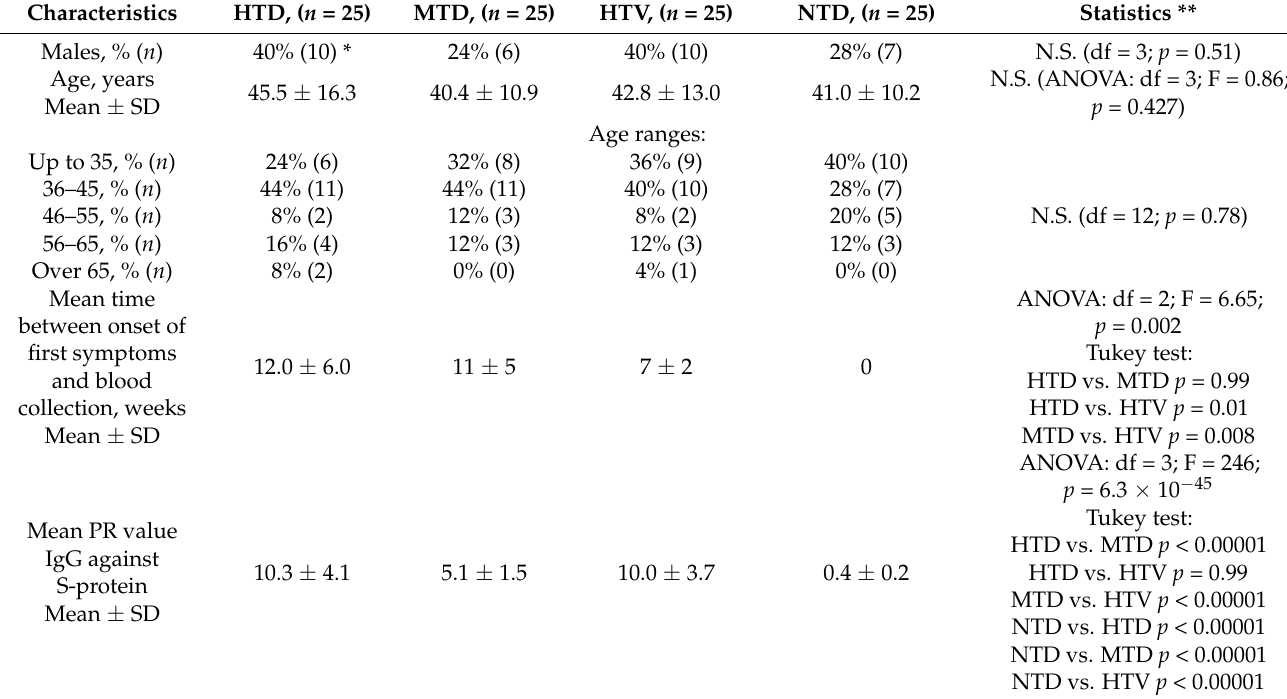
Table 1. Characteristics of patients and donors in the study